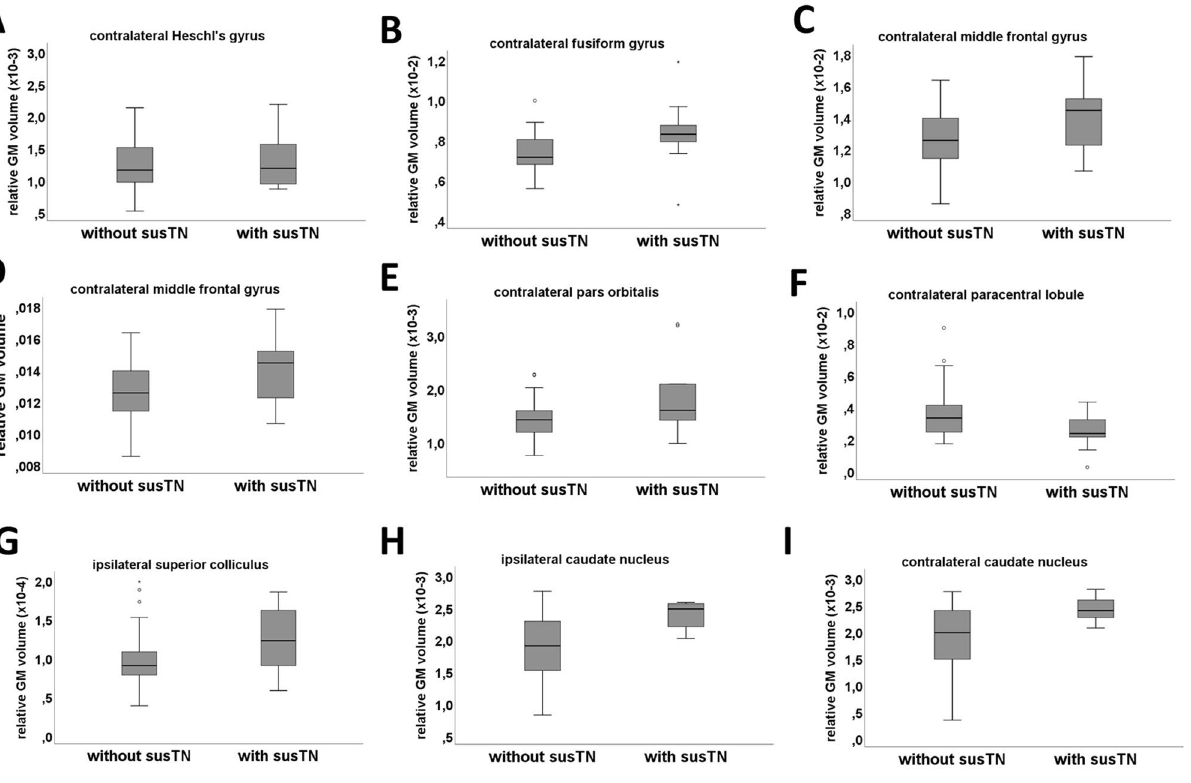
Figure 3. There was no volumetric change of the contralateral Heschl’s gyrus ( A ). However, there were significant GM changes in VS-associated tinnitus for the contralateral fusiform gyrus ( B ), the contralateral middle temporal gyrus ( C ), the contralateral medial gyrus ( D ), the contralateral pars orbitalis ( E ), the contralateral paracentral lobule ( F ), the ipsilateral superior colliculus ( G ) and the ipsilateral ( H ) as well as contralateral caudate nucleus ( I ). Data is shown in boxplot ( thick line : median; box width : first and third quartiles; whiskers : minimum and maximum values; circle and asterisks : outliers and